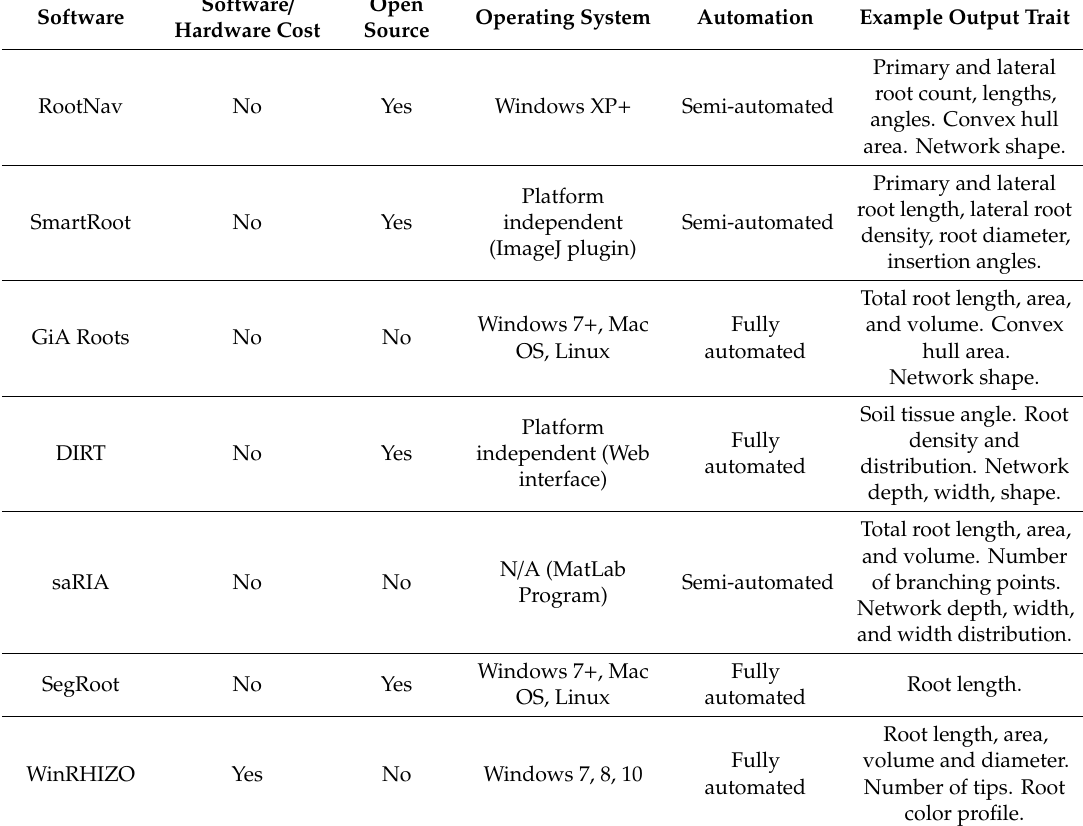
Table 2. Commonly used image-based tools for root phenotyping in